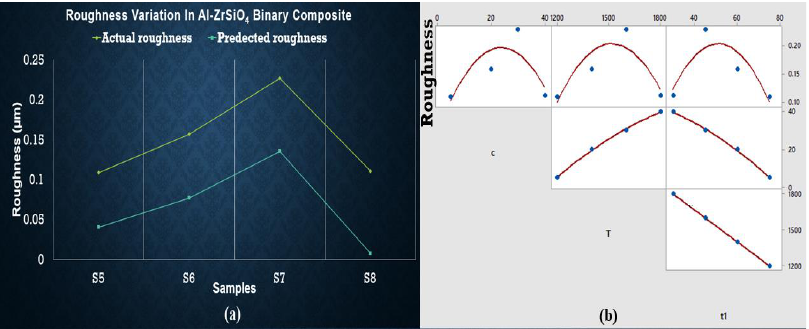
Figure 9. ( a ) Regression plot for Al-ZrSiO 4 showing overlapping of actual and predicted roughness values points (yellow line presents actual value of hardness and blue line shows predicted values). ( b ) Matrix plot showing the individual relationship between roughness and input variables for Al-ZrSiO 4 .